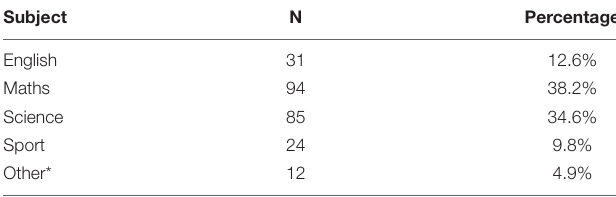
TABLE 2 | Social Comparison Subject selection.